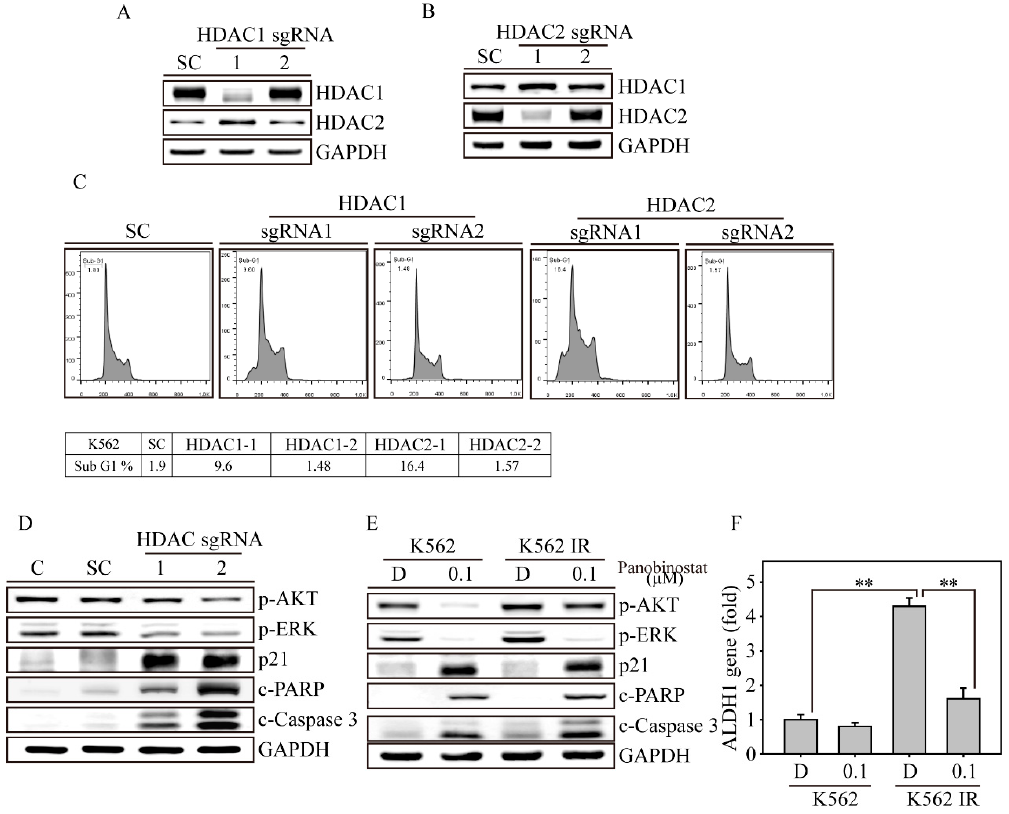
Figure 6. HDAC1 and HDAC2 inhibition induced cell apoptosis in both K562 and K562-IR cells. Immunoblot analysis of protein expression in ( A ) HDAC1 and ( B ) HDAC2 gene-edited K562 cells. ( C ) HDAC1 and HDAC2 gene-edited K562 cells were analyzed for a sub-G1 population by flow cytometry. ( D ) HDAC1 and HDAC2 gene-edited cells were analyzed for signal transduction (p-AKT and p-ERK), cell cycle (p21) and apoptosis-related protein expression compared to control and SC K562 cells. ( E ) K562 and K562IR cells with or without 0.1 µ M panobinostat treatments were analyzed for signal transduction (p-AKT and p-ERK), cell cycle (p21) and apoptosis-related protein expression. GAPDH immunoblotting served as an internal control. ( F ) ALDH1 gene expression was analyzed in K562 and K562IR cells with or without 0.1 µ M panobinostat treatment for 24 h. The gene expression was measured by real-time PCR (Q-PCR). Data are presented as the mean and standard deviation